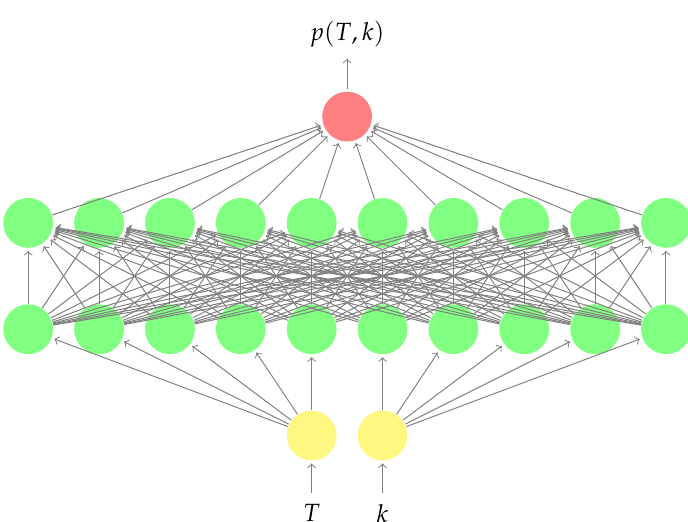
Figure 2. A shape preserving (sparse) feed forward architecture with one hidden layer containing 10 hidden nodes. The first input variable, T , is only connected to the five left most hidden nodes and the second input variable, k , is only connected to the five right most hidden